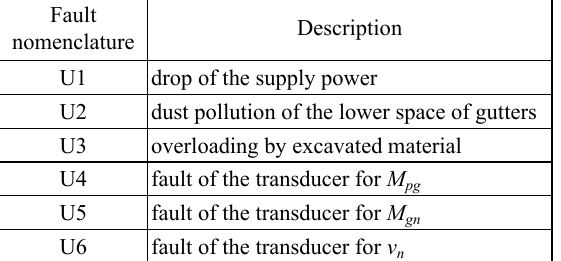
Table 5. Possible faults in the simulator Fault